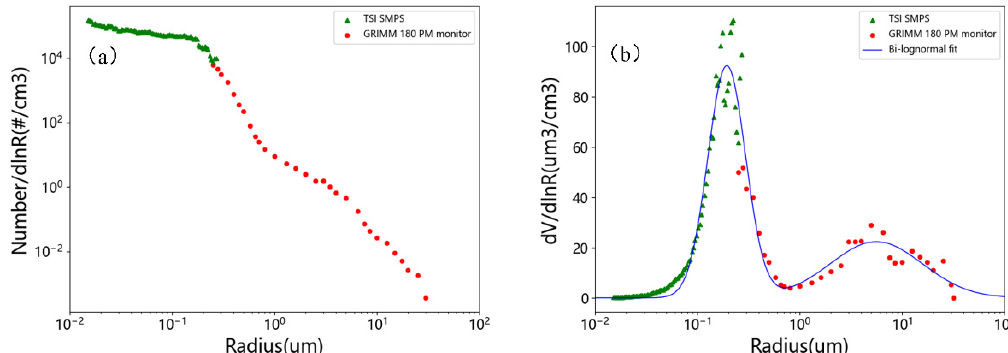
Figure 4. The aerosol size distribution for the surface expressed by ( a ) the particle number concentration on 24 December 2014; and ( b ) the corresponding volume concentration. The data were obtained by splicing the synchronous observations of the TSI SMPS and GRIMM 180 PM monitor.